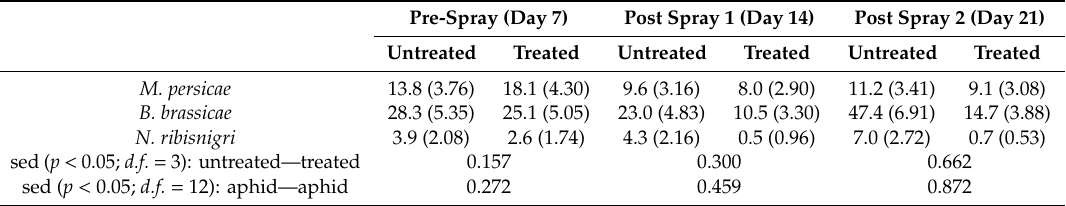
Table 10. Mean total number of M. persicae , B. brassicae , and N. ribisnigri recorded per plant after two treatments with Botanigard ES in field experiment 2 (square root-transformed data are given in parentheses). Applications of Botanigard ES were done on days 7 and 14 after inoculation of plants with aphids. Counts of aphid numbers were done immediately prior to spraying on day 7 and day 14, and 7 days after the second spray ( = day 21).